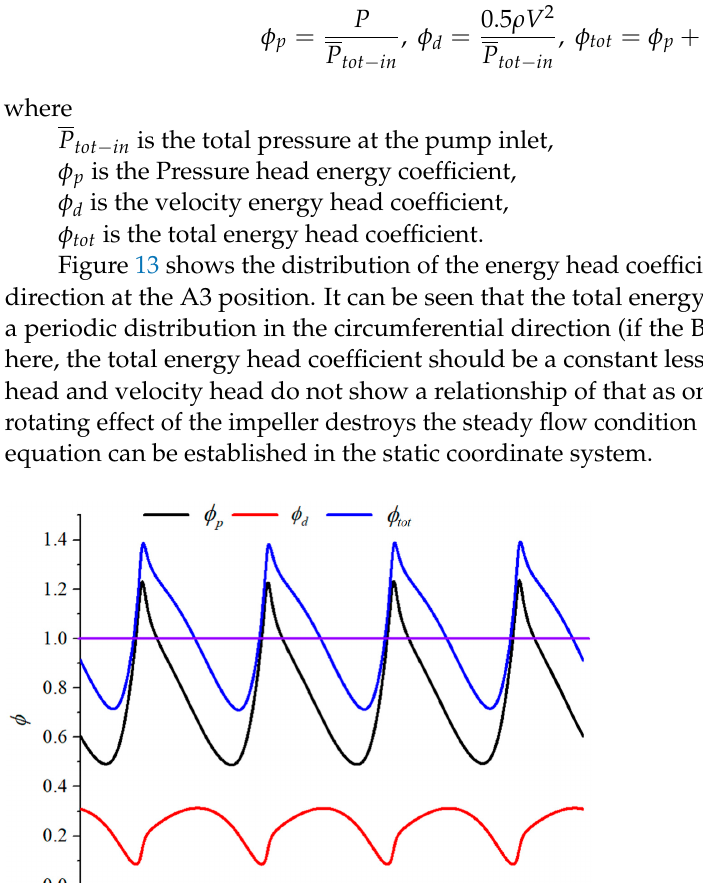
where, out P and in P are the average pressure at the measuring point of the pump inlet and outlet pressure gauge, respectively. pump inlet and outlet measuring point are located.